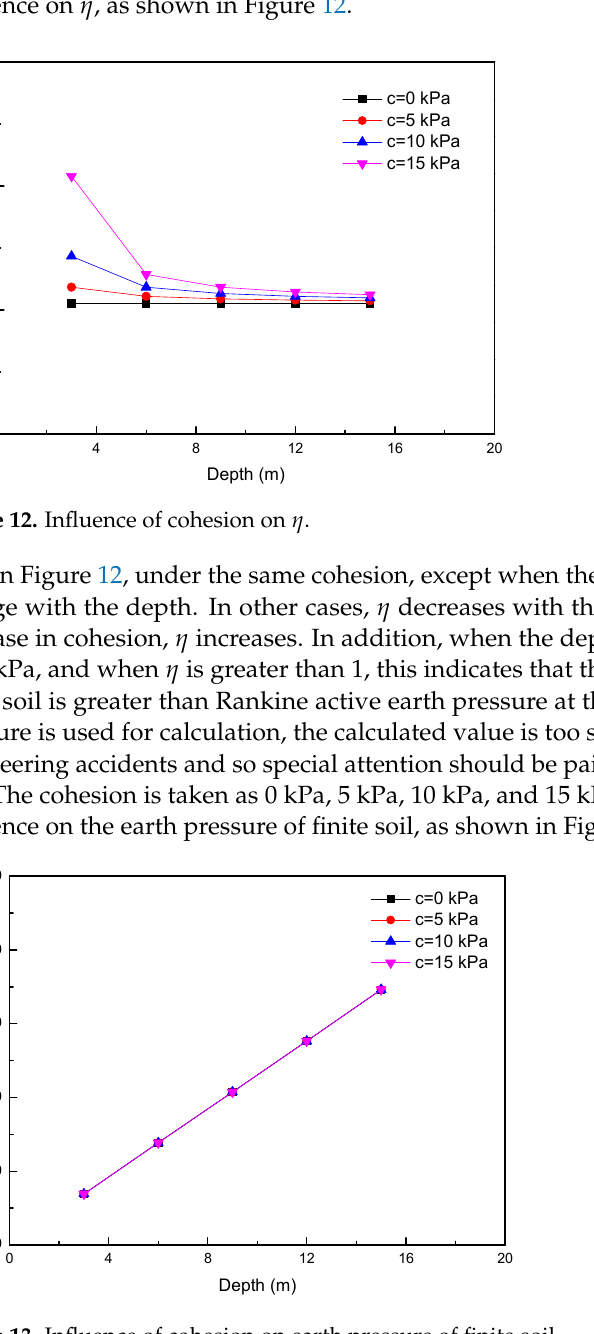
Figure 11. Influence of width-to-depth ratio on earth pressure of finite soil.